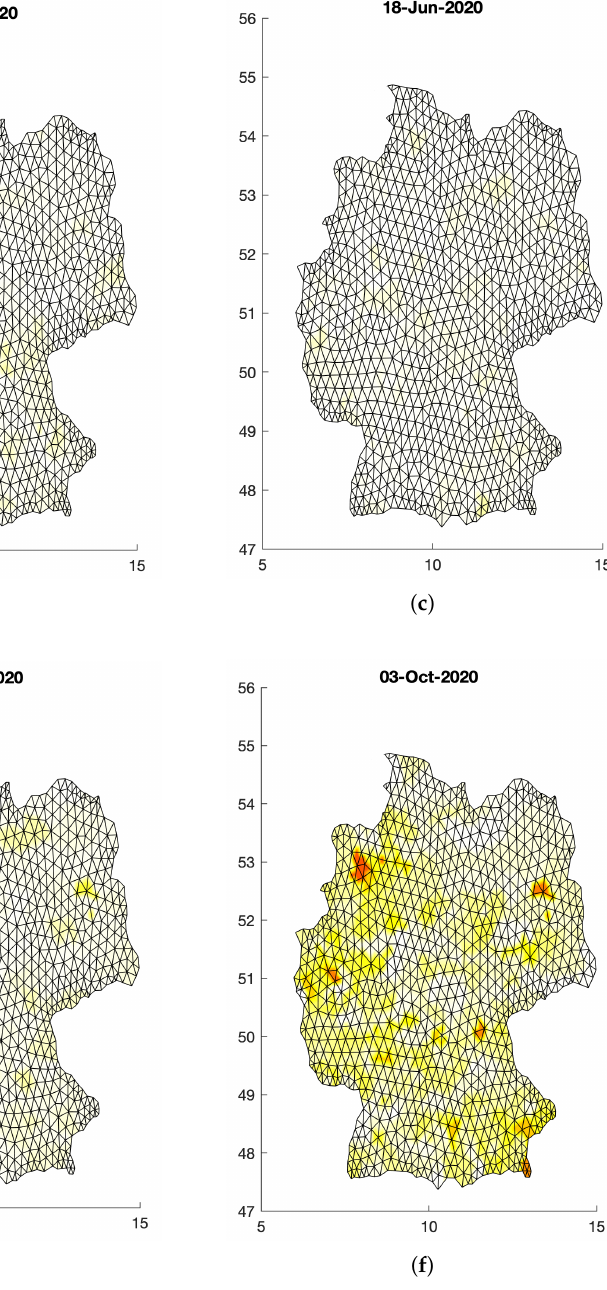
Figure 8. Regional spread of the virus at different time stages after initial outbreak on day 1 (D1). ( a ) D55, ( b ) D100, ( c ) D150, ( d ) D200, ( e ) D235, ( f )